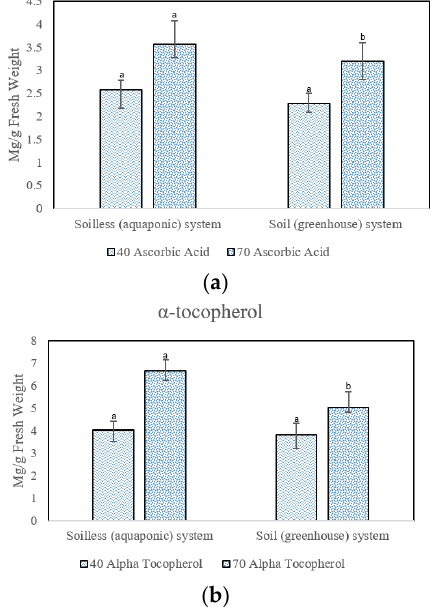
Figure 4. Ascorbic acid ( a ) and α -tocopherol ( b ) concentrations of Ocimum basilicum in (aquaponic) and soil (greenhouse) systems at 40 and 70 DAS. Values are given as mean ± SD of seven samples in each group. Values that do not share a common superscript (a, b) differ significantly at p ≤ 0.05 using t -test.